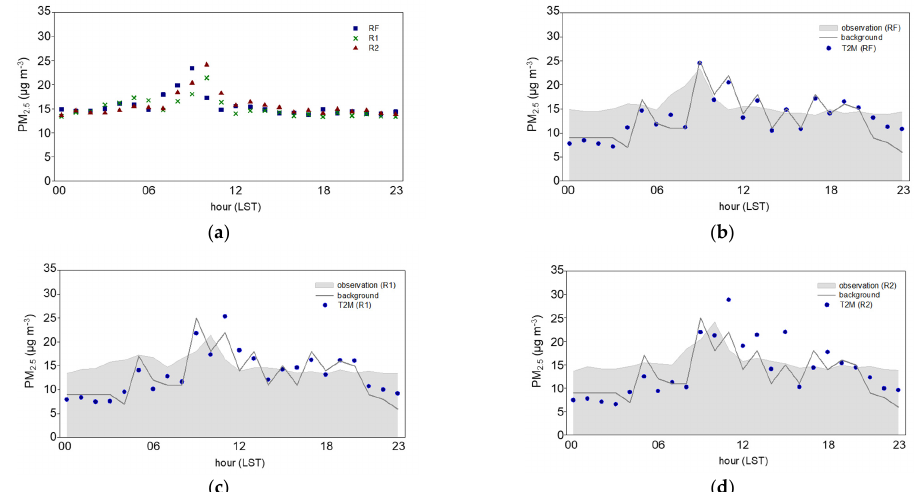
Figure 4. ( a ) Time series of the measurement, and measured and simulated PM 2.5 concentrations at ( b ) RF, ( c ) R1, and ( d ) R2 (green and yellow dots in Figure 1a).